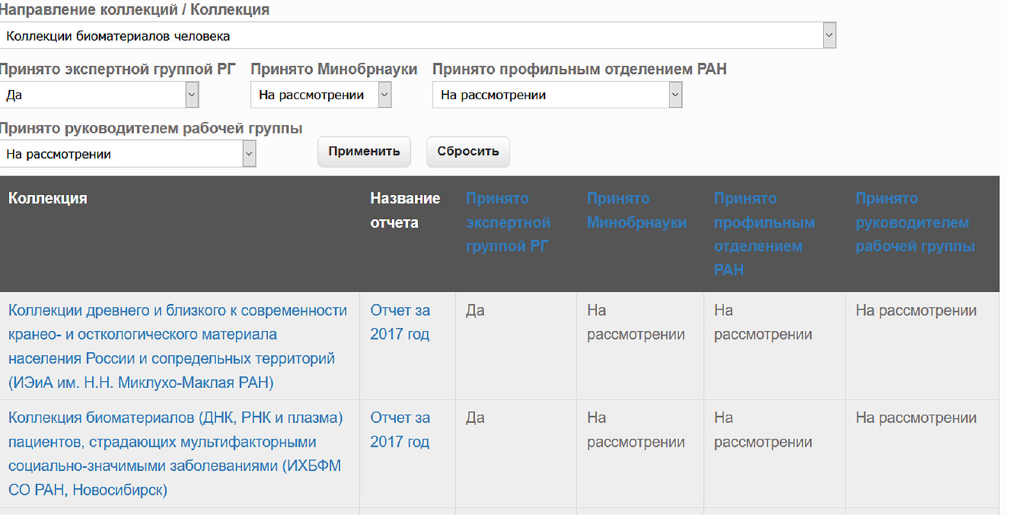
Figure 6: The list of reports on the work of collections of a particular direction over the past year, selected according to several criteria and used by experts in this area in the process of assessing